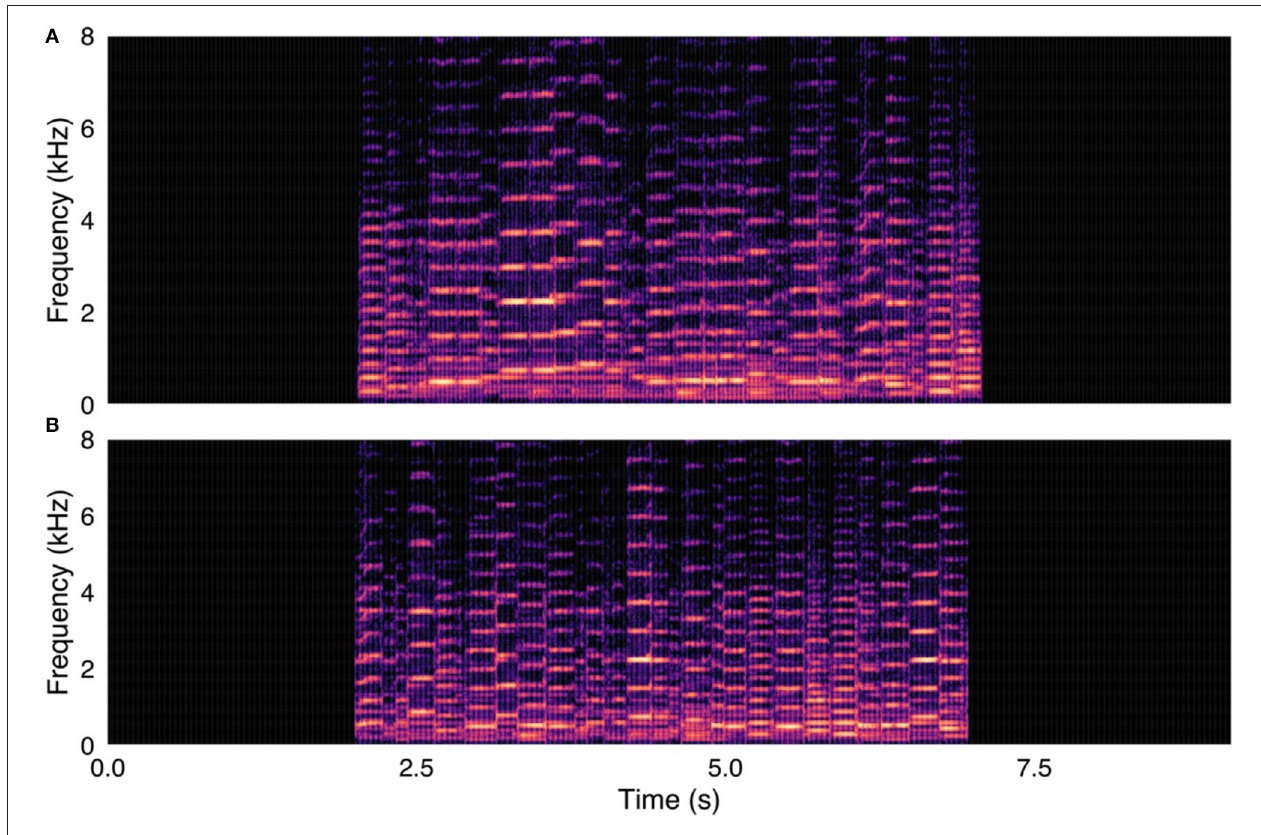
FIGURE 2 | ( A , upper panel) Control stimulus from survey. Human fiddle music recording, with notes in original temporal order. ( B , lower panel) Same fiddle music recording, with notes in randomized temporal order. Spectrograms were created with were created using a 1024-point FFT and a Hamming window with 87.5% overlap.